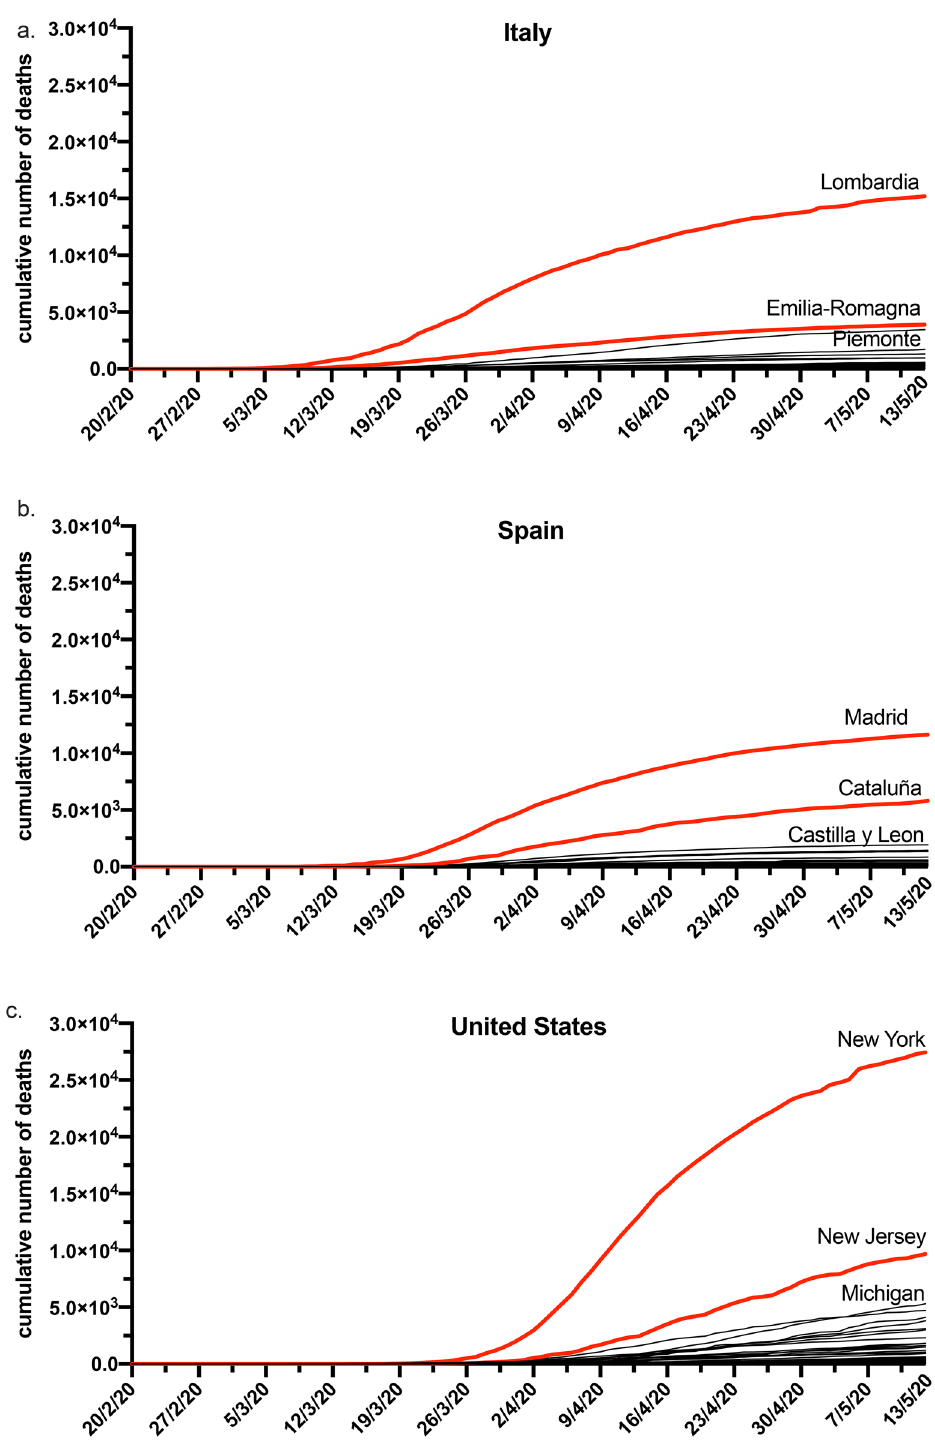
Figure 2. Plots of the cumulative number of deaths per geopolitical region for: ( a ) Italy; ( b ) Spain; ( c ) United is the most significant with the lowest p values and the largest overall R 2 values for the Italy and Spain data. It has also a significant p value and sizable R 2 for the United States. This indicates that tweet intensity is the most significant variable for the prediction of the number of deaths for Italy and Spain. For the United States we still observe that tweet intensity is a significant predictor for the number of deaths but results from unweighted regression with model-2 and model-3 reveal that the population of the regions is a better predictor.